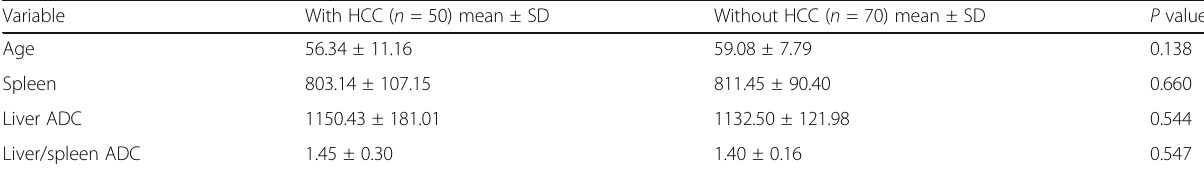
Table 3 Age and different ADC measurements between patients with and without HCC among the cases group Variable